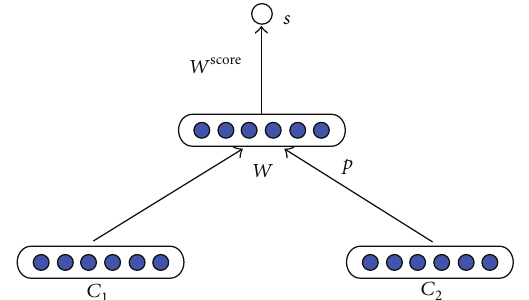
Figure 3: Recursive neural network which is replicated for each pair of input